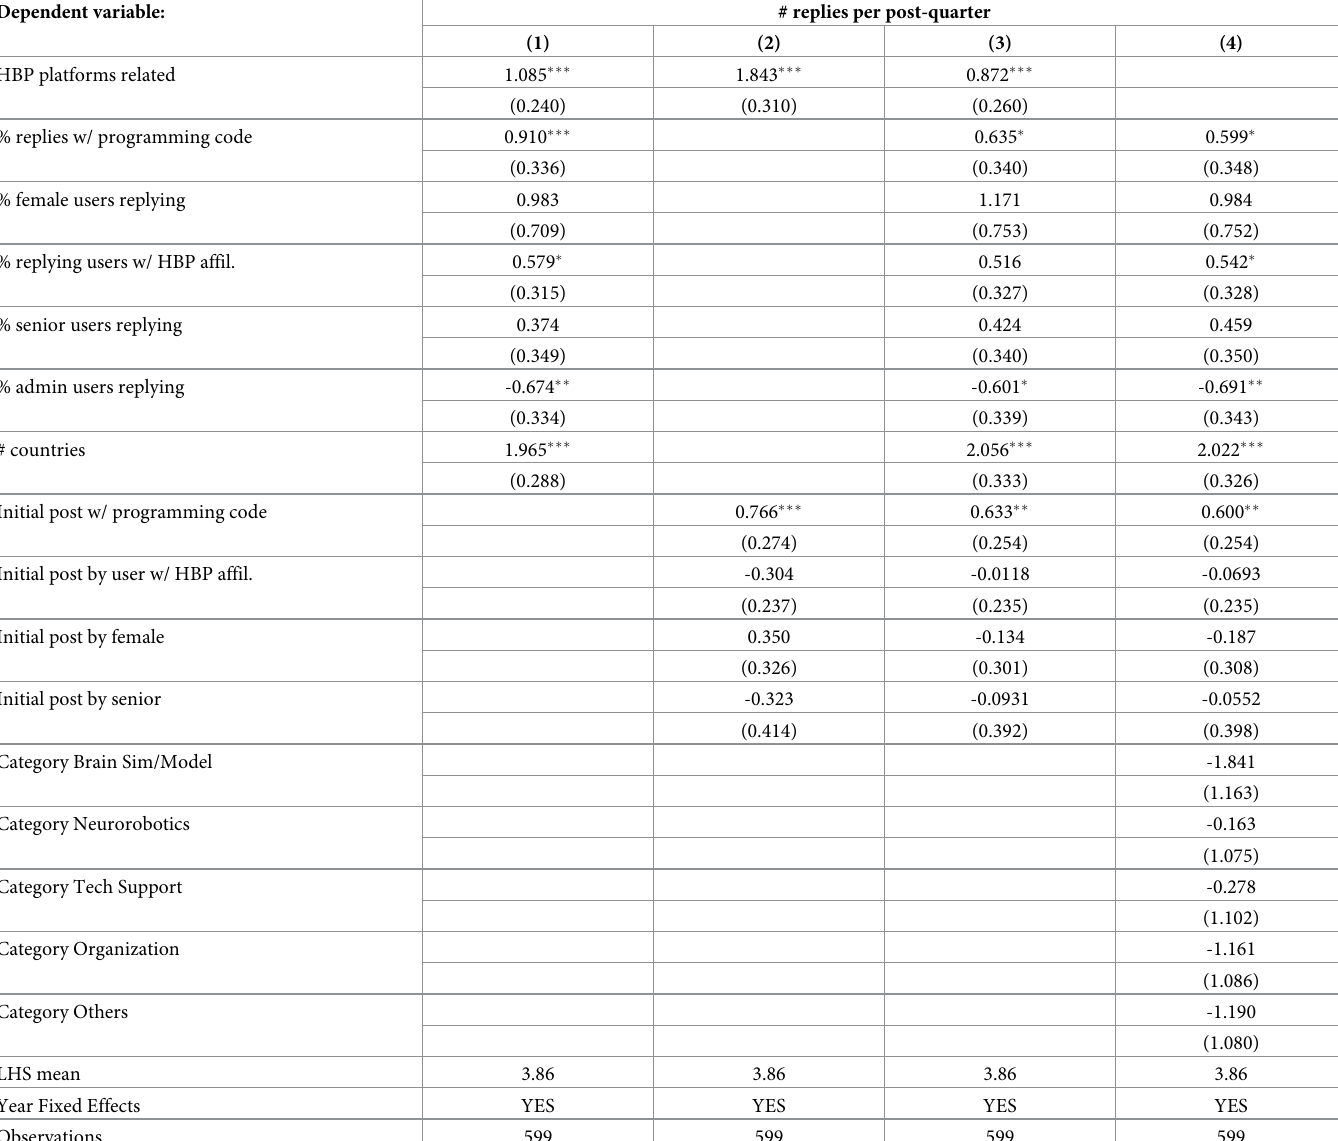
Table 2. HBP Forum utilization analyses at the post-quarter